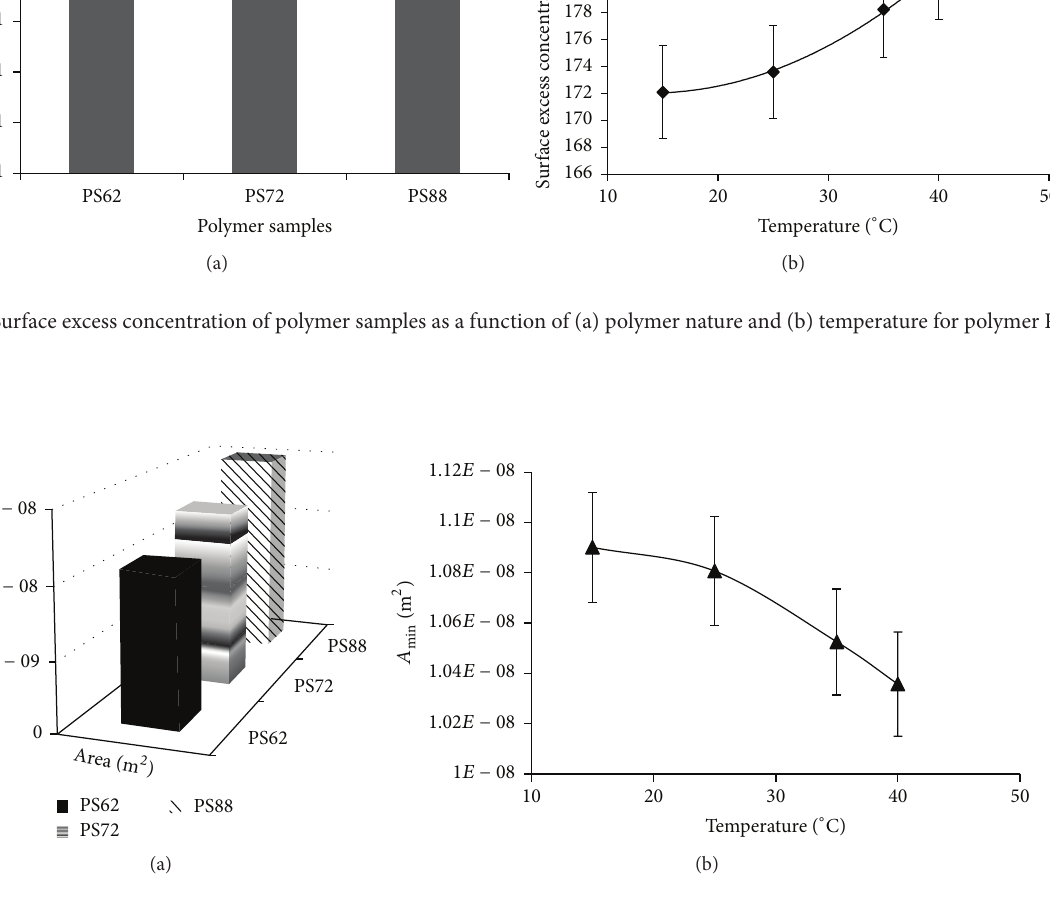
Figure 9: Minimum area per molecules (a) of various polymer samples measured at 25 ∘ C and (b) as a function of temperature for PS62